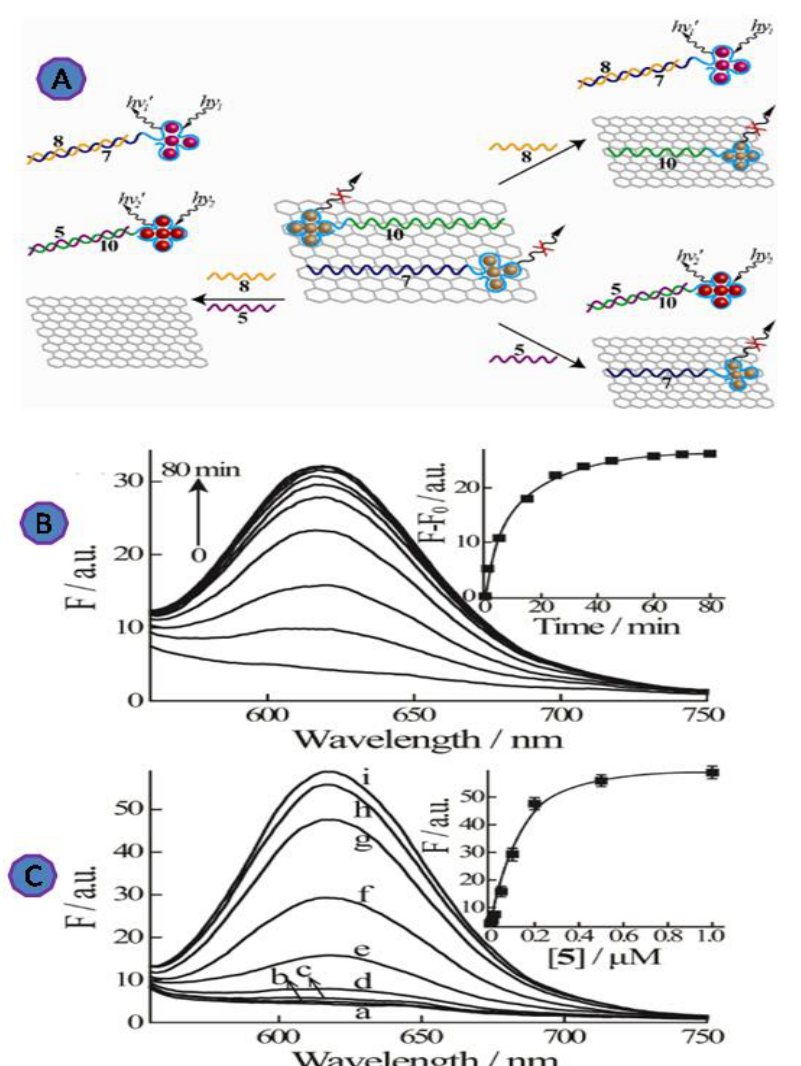
Figure 13. ( A ) Schematic diagram of the multiplexed detection platform for the HBV gene (5) and the HIV gene using near-infrared and red-emitting AgNC probes (8); ( B ) time-dependent fluorescence spectra of the red-emitting AgNCs upon challenging the (6)-AgNCs/GO with the HBV target gene (5), 100 nM. Inset: Time-dependent fluorescence changes at λ = 616 nm upon analyzing (5) by the (6)-AgNCs/GO. ( C ) Fluorescence spectra of the AgNCs upon analyzing different concentrations of the HBV gene (5) by the (6)-AgNCs/GO system. (a) 0, (b) 2 nM, (c)10 nM, (d) 20 nM, (e) 50 nM, (f) 100 nM, (g) 200 nM, (h) 500 nM, and (i) 1000 nM. Fluorescence spectra were recorded after a fixed time-interval of 80 min. Inset: Calibration curve corresponding to the luminescence of the related AgNCs (at λ = 616 nm) in the presence of different concentrations of (5). Reprinted with permission from Ref. [84]. Copyright 2013, American Chemical Society.